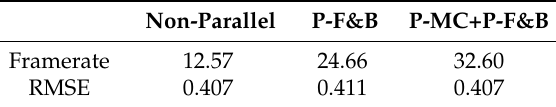
Table 4. Frame rate comparison of parallel multi-constraint front-end, where a higher frame rate is obtained by our parallel framework. Such a higher frame rate is beneficial to data association due to a shorter